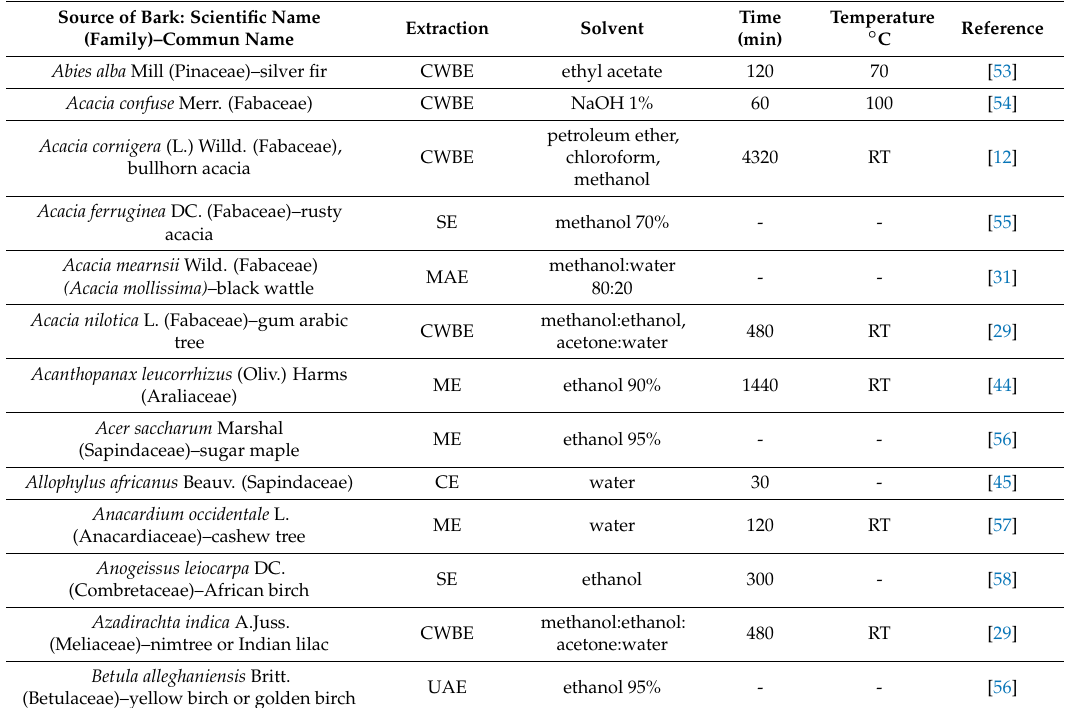
Table 1. Factors involved in different extraction methods according to the studied